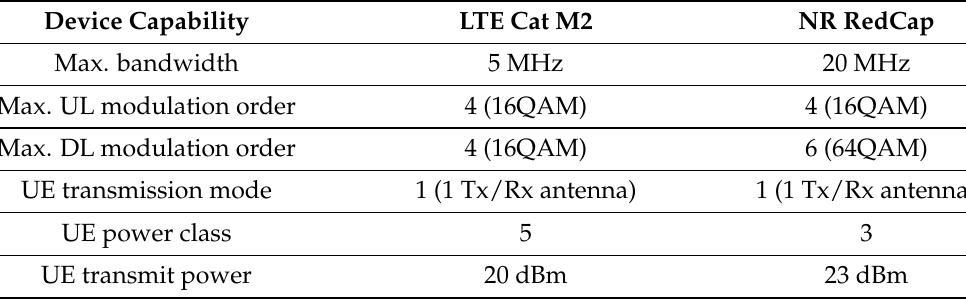
Table 4. Main capabilities of LTE Cat M2 and NR RedCap